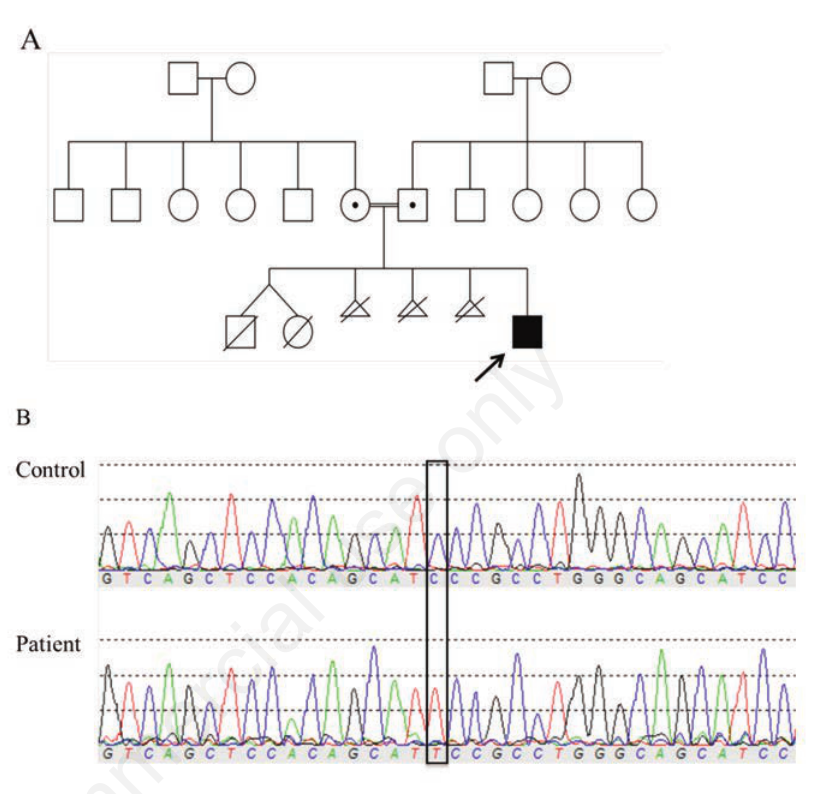
Figure 1. (A) Pedigree of the affected family and (B) representative chromograph of SLC22A5 Sanger sequencing read. Black rectangle indicates the affected nucleotide; c.1409C>T (NM_003060.3).